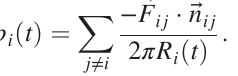
FIG. 8. (a) Two contacting cells i and j with radii R The center-to-center distance between two cells is r , given in Eq. (A2). (b) The force on cell i and the overlap is h ij due to cell j , F , is plotted as a function of the separation r ij ¼ R ¼ 1 . 5 . The inset reveals the short-range attractive force. R i j ¼ 0 if there is no contact; i.e., r F ij